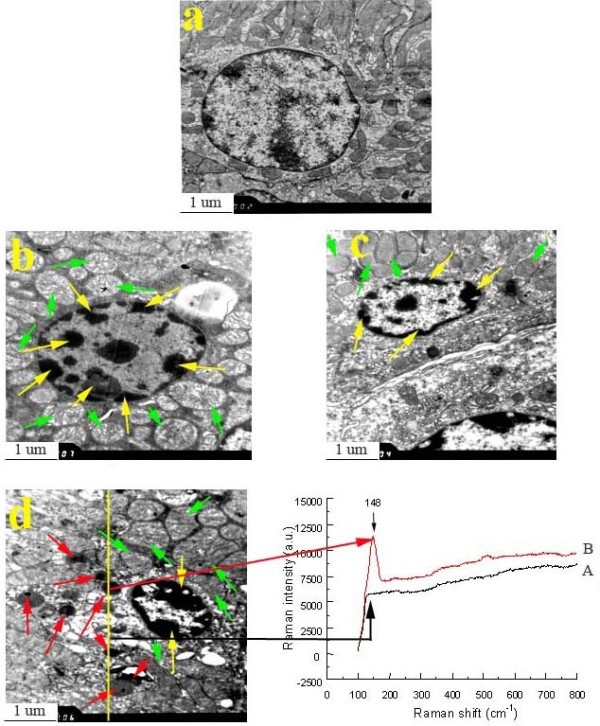
Ultrastructure of kidney in male mice caused by intragastric administration of TiO2 NPs for 90 consecutive days. (a) Control, (b) 2.5 mg/kg TiO2 NPs, (c) 5 mg/kg TiO2 NPs, (d) 10 mg/kg TiO2 NPs. Yellow arrows indicate nucleus shrinkage, chromatin marginalization, green arrows indicate mitochondria swelling, and red arrows show presence of TiO2 NPs. Arrow A spot is a representative cell that not engulfed the TiO2 NPs, while arrow B spot denotes a representative cell that loaded with TiO2 NPs. The right panels show the corresponding Raman spectra identifying the specific peaks at about 148 cm-1.